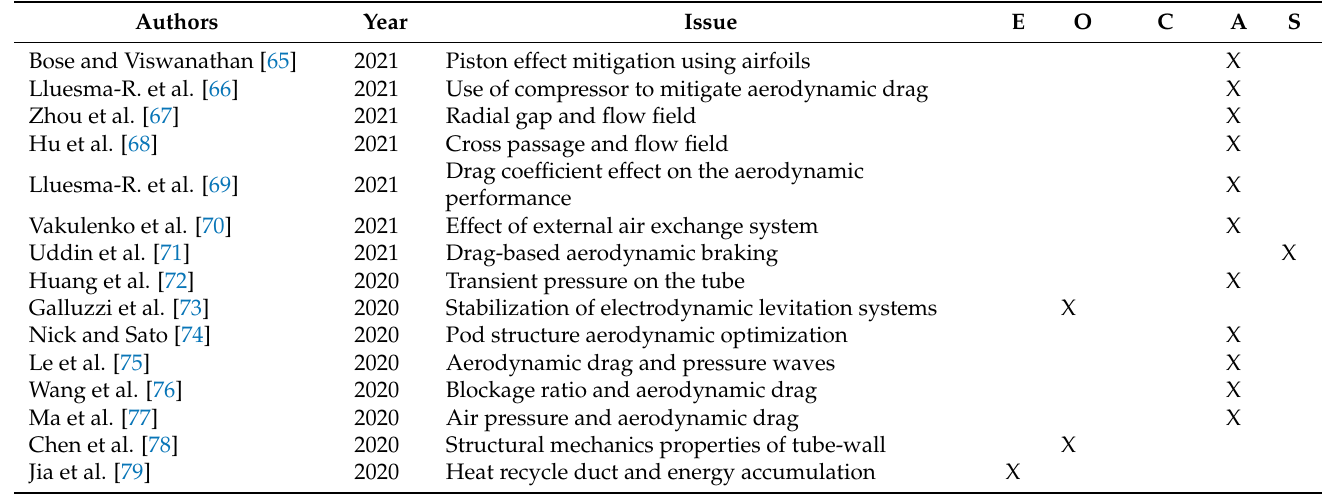
Table 4. Issues identified in research on Hyperloop tube-pod